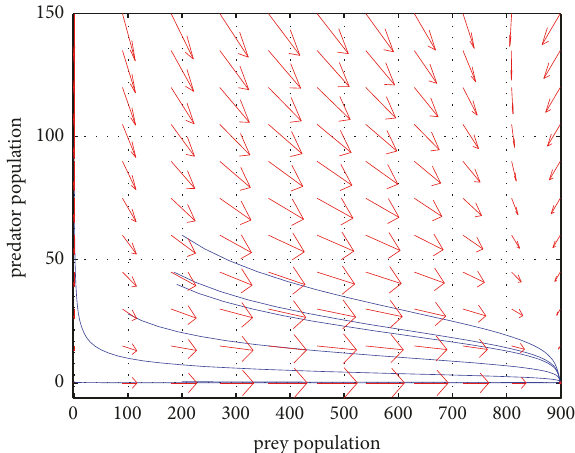
Figure 3: The phase portrait of model (2) with weak Allee effect. The parameters are taken as 𝑥(0) = 260 , 𝑦(0) = 70 , 𝐴 = 0.01 , 𝑟 = 2.65 , 𝐾 = 900 , 𝑎 = 0.02 , 𝑐 = 0.215 , and 𝑚 = 1.06 ; 𝐸 asymptotically stable, with no limit cycle.